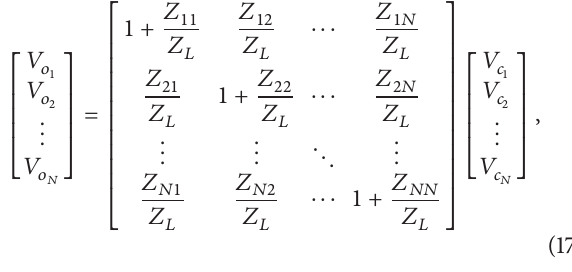
Figure 4: Effect of 𝜉 𝑑 on output SINR of a 6-element array of half- wavelength, center-fed